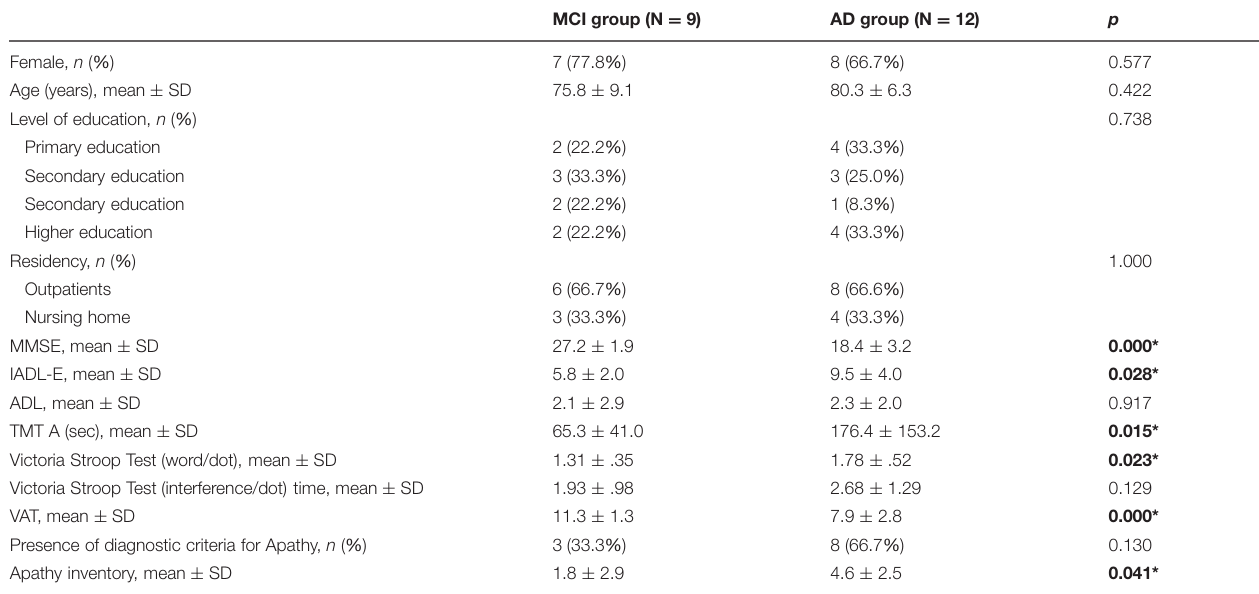
TABLE 1 | Characteristics and group comparisons for mild cognitive impairment (MCI) and Alzheimer’s disease (AD)